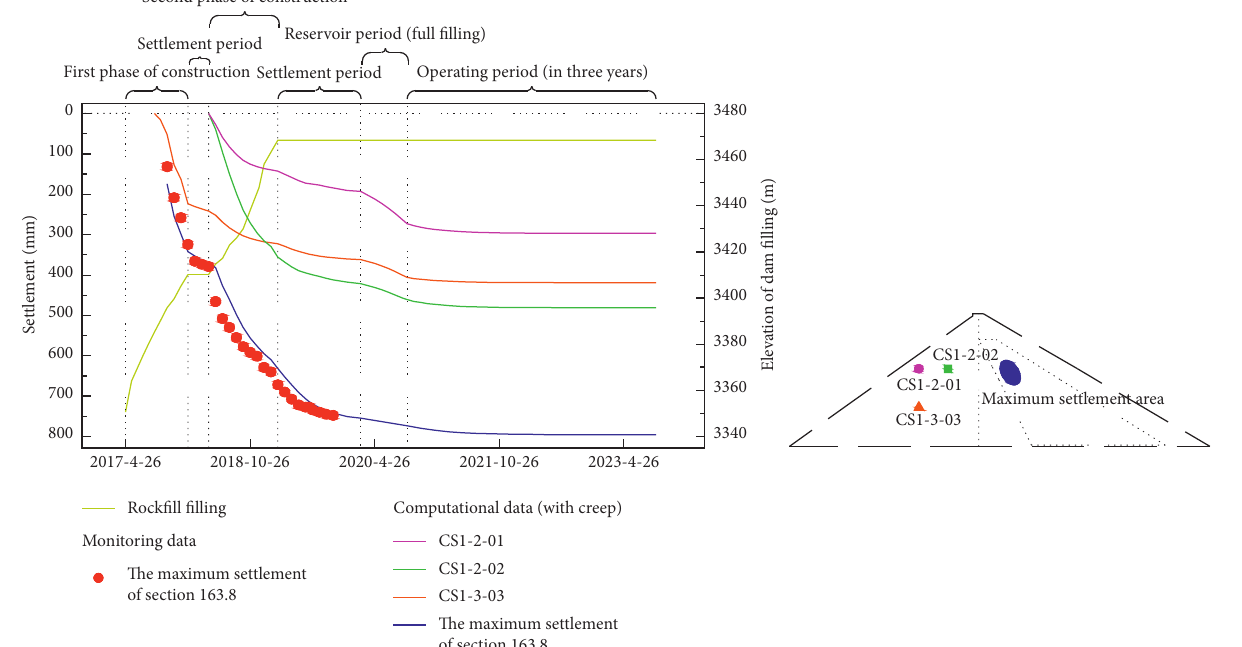
Figure 13: The settlement monitoring results of Xujixia CFRD